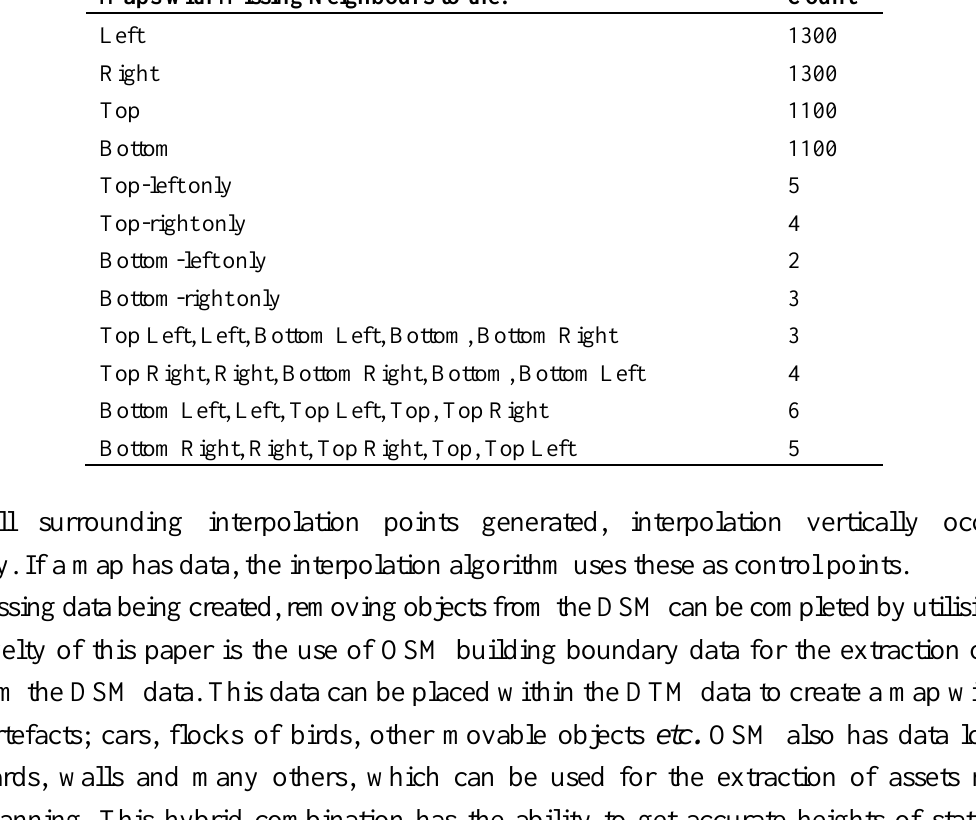
Table 3. Showing the number of maps which do not have certain neighbour maps, for 2 m and 1 m LiDAR maps covering 1 km 2 and 1 km 2 subsections of OS maps. Maps with Missing Neighbours to